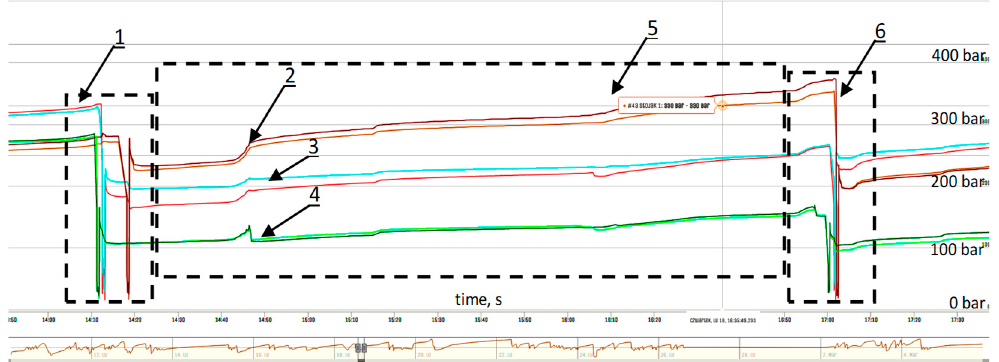
Figure 4. Measurement of the pressure difference in the legs of the powered support: 1, work performed by the support (leg withdrawal, readjustment, expanding; 2, powered support no. 43; 3, powered support no. 44; 4, powered support no. 45; 5, powered support operation at working-load capacity; 6, support